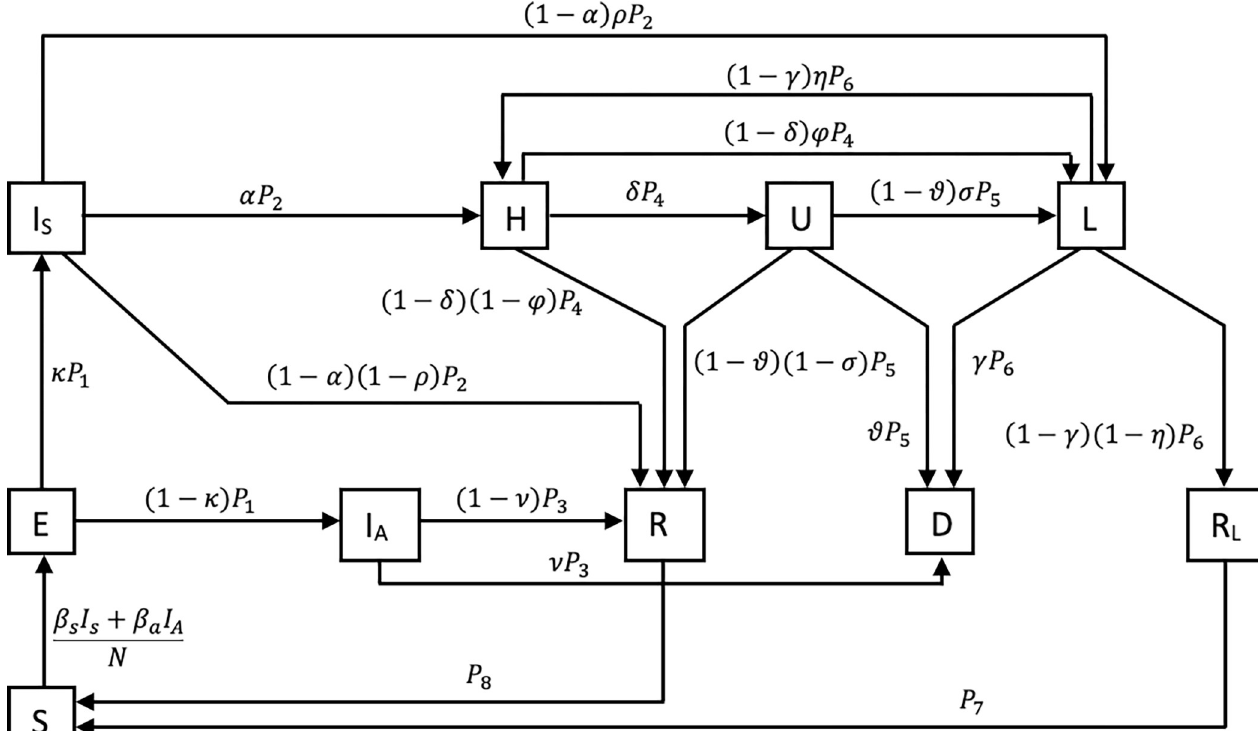
Fig 1. Compartmental SEIR model. Legend: An individual in age group i is classified either as susceptible (S), exposed (E), asymptomatically infected (I A ), symptomatically infected (I S ), hospitalised (H), in intensive care (U), suffering under long-COVID (L), fully recovered (R F ), recovered from long-COVID (R L ), and dead (D). P 1 − P 8 are health state transition rates. The Greek letters quantify transition probabilities between the statuses.